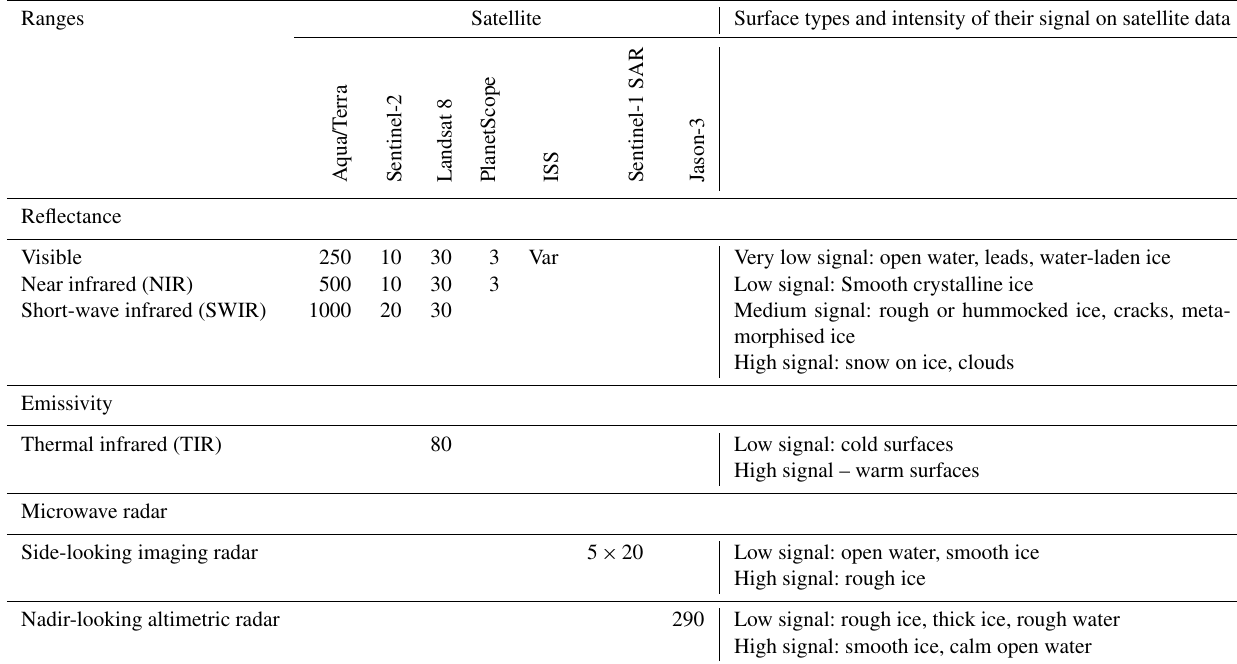
High signal: snow on